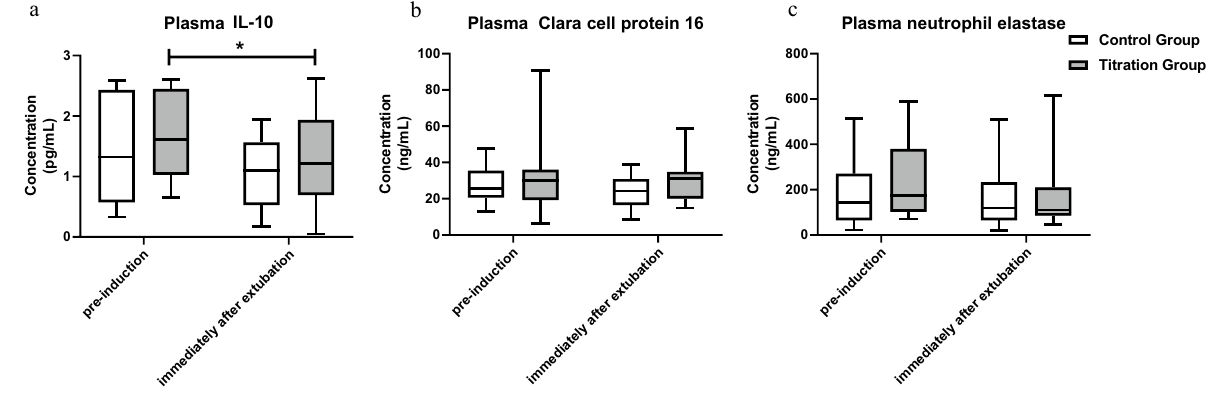
Figure 5. Box-whisker plots for plasma concentrations of IL-10 ( a ), CC16 ( b ), and NE ( c ) at different time points. Line at median, top of the box at the 75th percentile, bottom of the box at the 25th percentile, whiskers at the highest and lowest values. IL-10 interleukin-10. CCP-16 Clara cell protein 16. NE neutrophil elastase. * p <